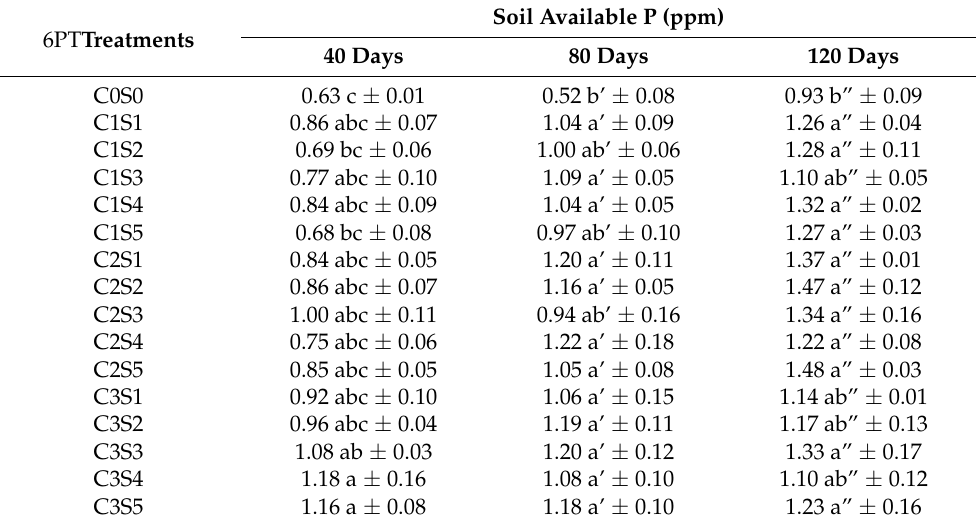
Means (value ± standard error) with different letters within the same column indicate significant differences using Tukey’s test with p ≤ 0.05. Small letters, small letters with ’, and small letters with ” indicate mean comparison at forty, eighty, and one hundred and twenty days incubation,